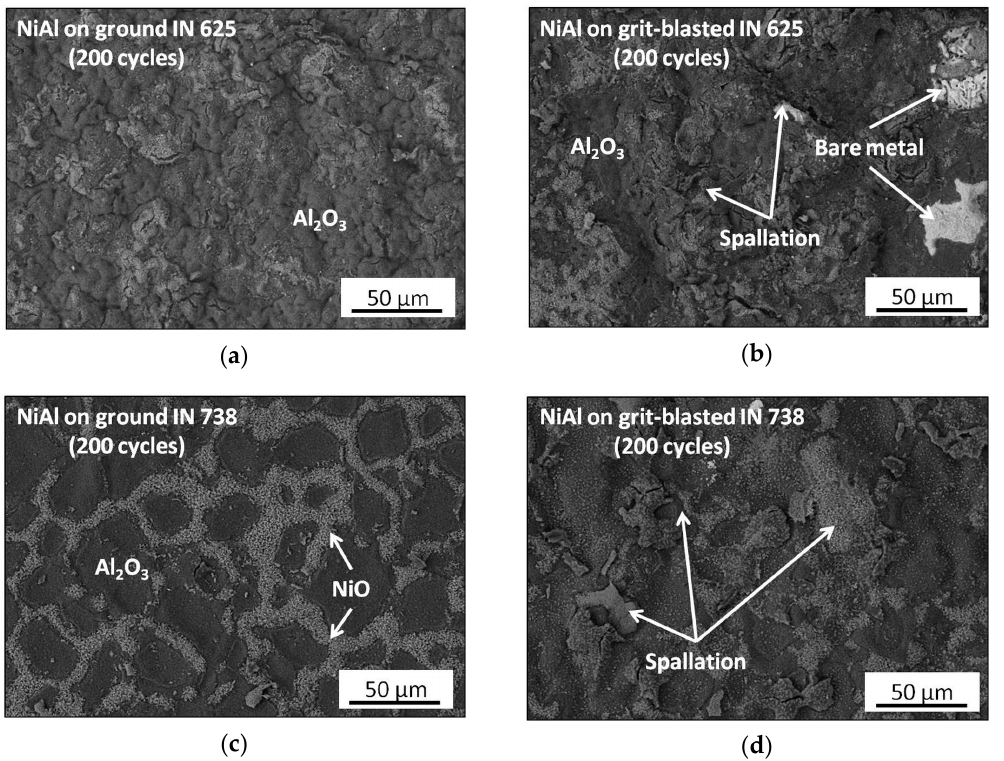
Figure 12. SEM / BSE images of the oxide scale formed on the surfaces of aluminide coatings grown on ( a ) ground IN 625, ( b ) grit-blasted IN 625, ( c ) ground IN 738, and ( d ) grit-blasted IN 738 after a thermal shocking test after 200 cycles.